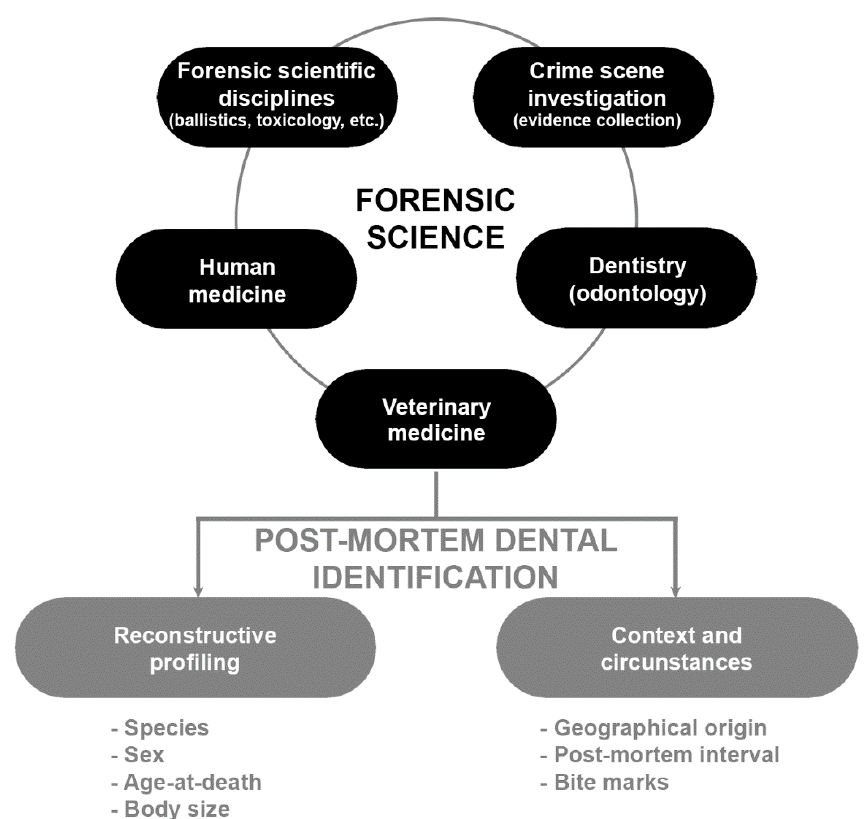
Figure 1. Diagram of the integration of veterinary medicine within the forensic sciences summarizing the main applications of dental profile in veterinary forensics.